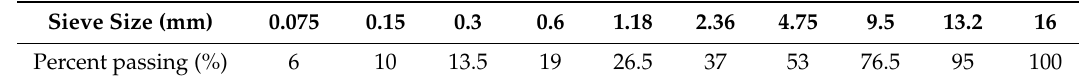
Table 4. Aggregate gradation of